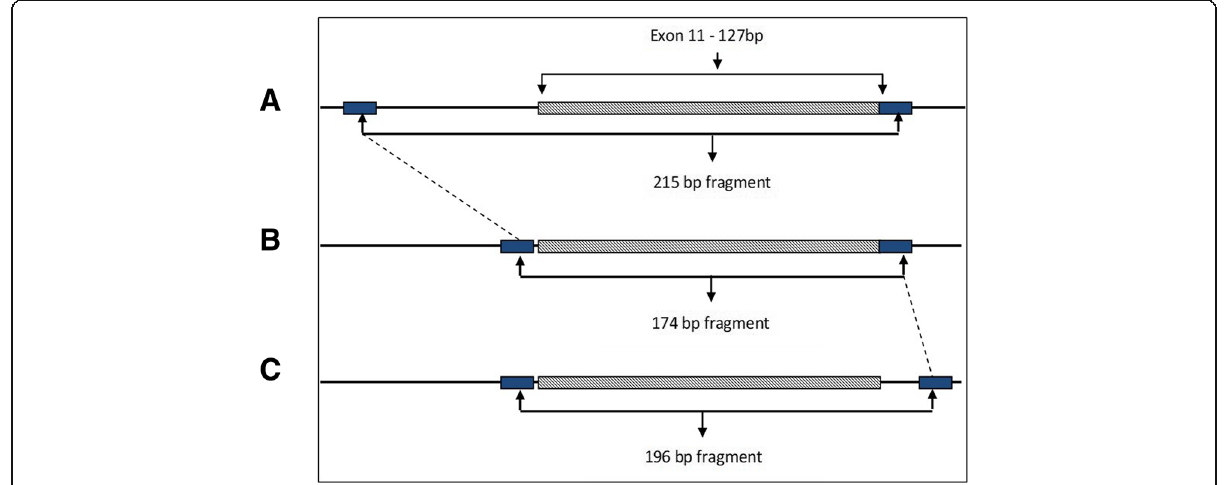
Fig. 2 Schematic figure showing 127 bp of the KIT gene exon 11 and the positions occupied by the primers used in this study. a 215 bp fragment; b 174 bp fragment and c 196 bp fragment. “ pm ”